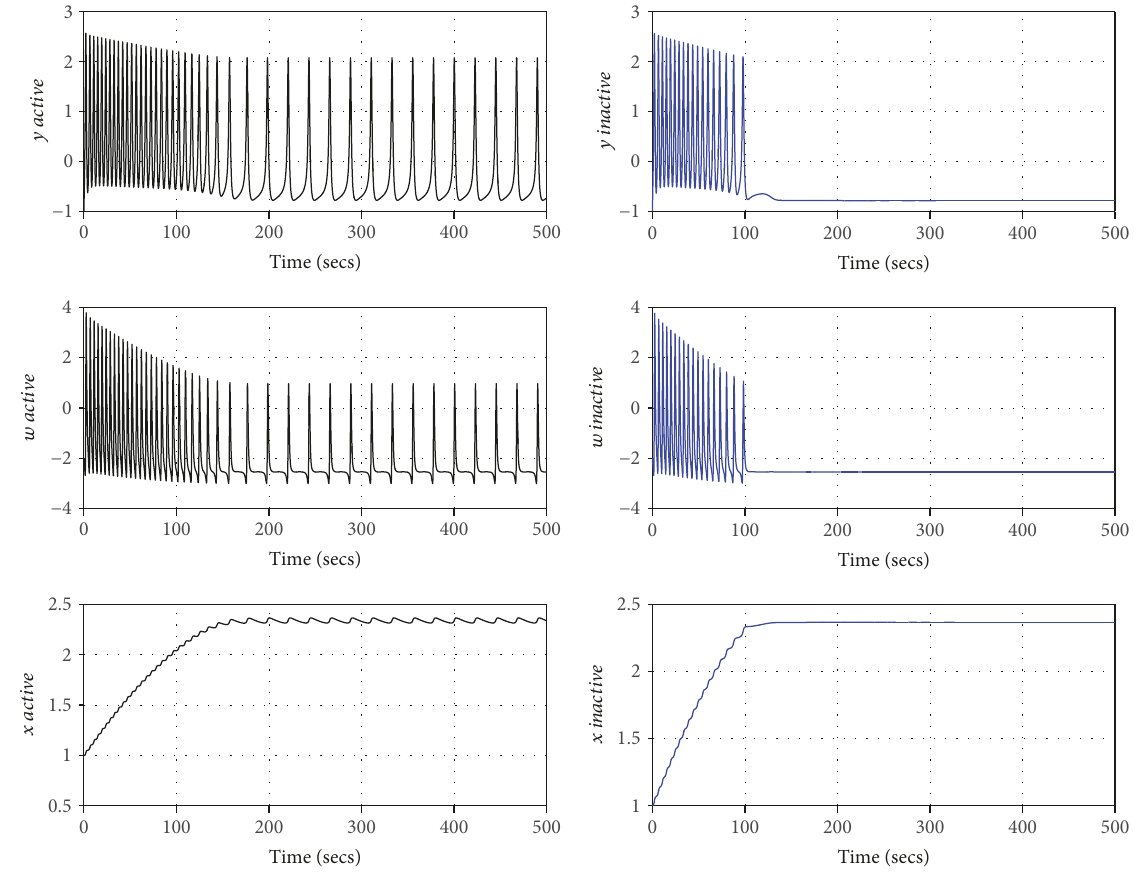
Figure 1: Behaviors of β -cells. The right and left columns correspond to active and inactive β -cells,